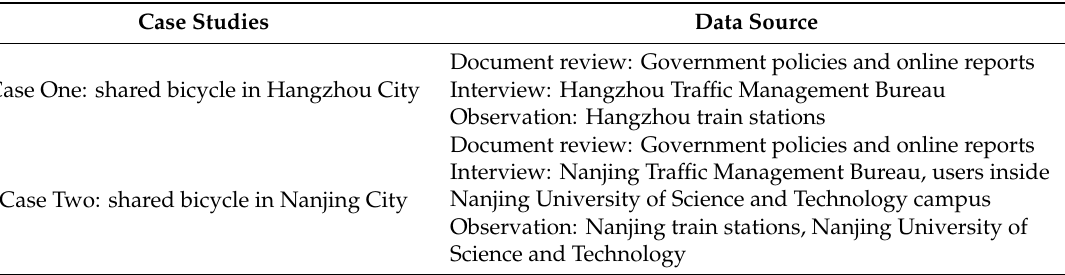
Table 1. Data source of case